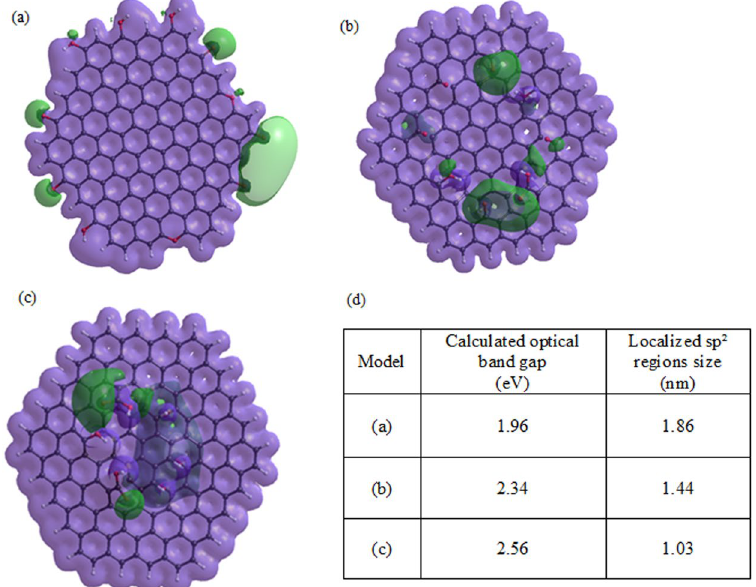
Figure 4. Computation of electrostatic potential of graphene sheet fragment with C = O, C-OH and C-O-C groups surrounding the region of graphitic carbon of the size of ( a ) 1.86 nm ( b ) 1.44 nm and ( c ) 1.03 nm. White, black and red atoms represent hydrogen, carbon, and oxygen, respectively for all the models. Green color represents negative electrostatic potential around the functional groups, whereas the purple color represents constant potential isosurfaces. ( d ) The table of calculated optical band gaps for the models (a), (b) and (c).